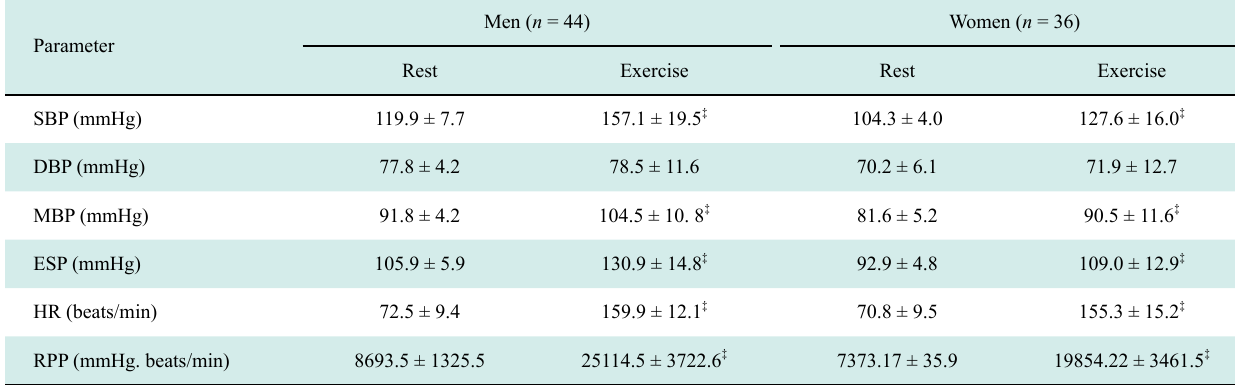
Table 1 Exercise test characteristics of the study group Parameter